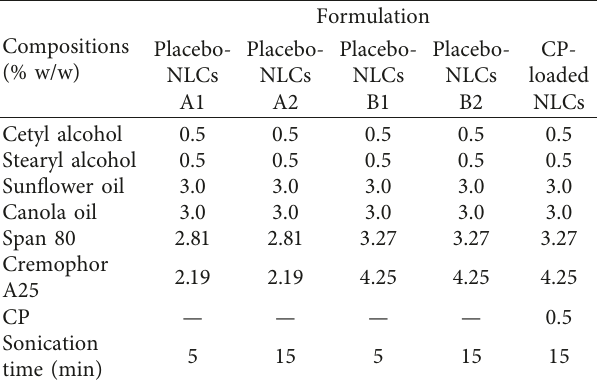
Table 2: Compositions of NLCs formulations (values are given in %